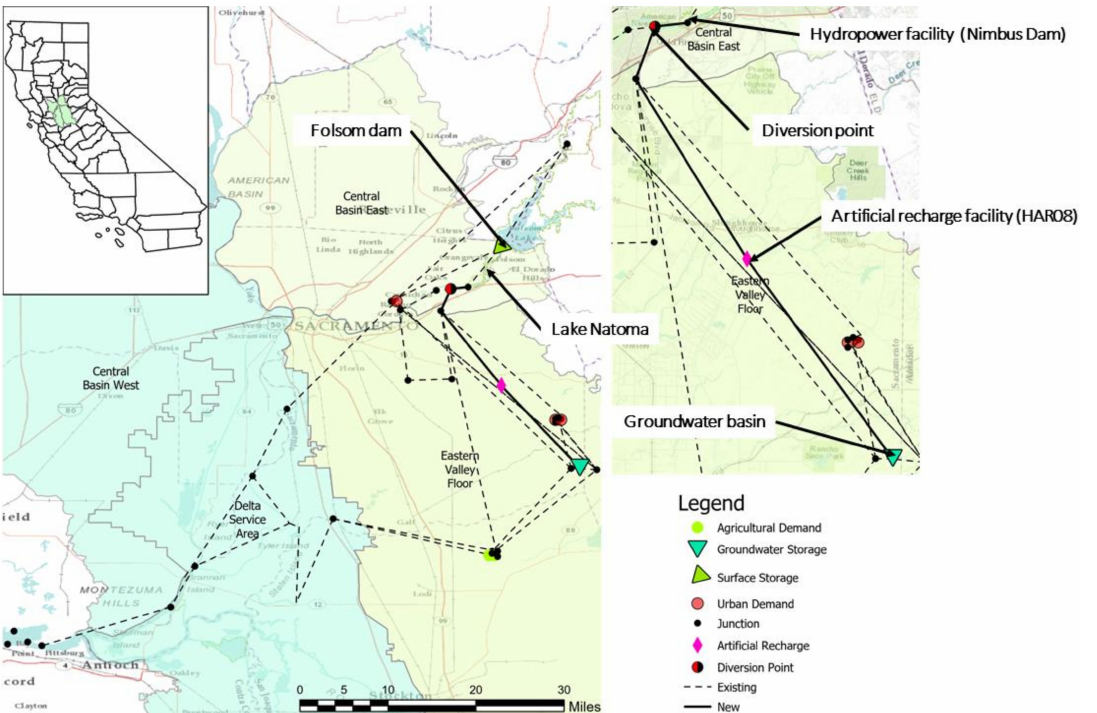
Figure 1. Study area map of the Folsom Lake area: this figure highlights California’s inter-tied network implemented in CALVIN, including major facilities, including surface water and groundwa- ter basins and new artificial recharge facilities connected by new conveyances, in solid black lines labeled